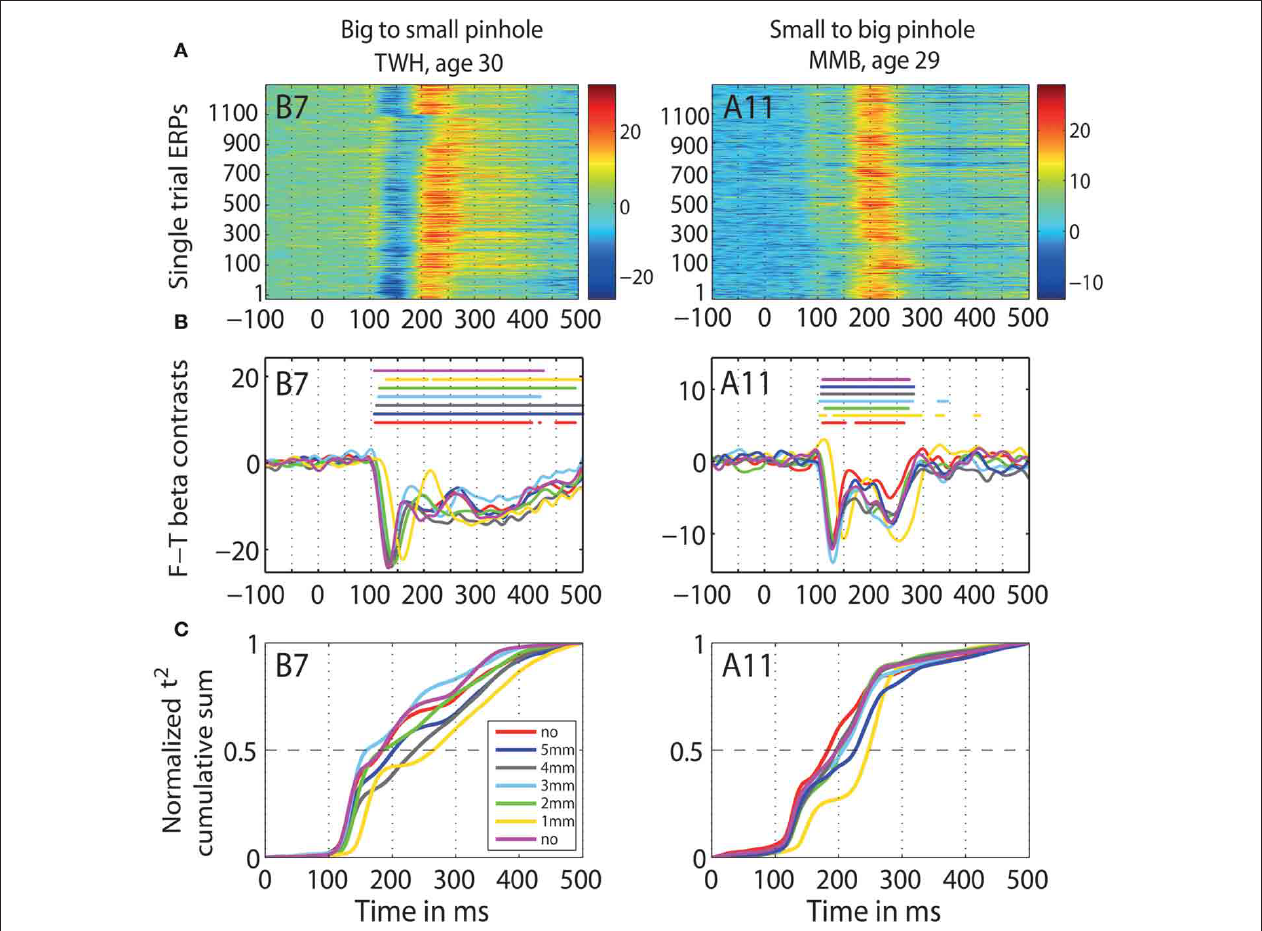
(B) Time-courses of contrasts between face and texture beta-coefficients for each pinhole condition. Horizontal lines indicate significant differences. (C) Cumulative sums of t 2 functions for each pinhole